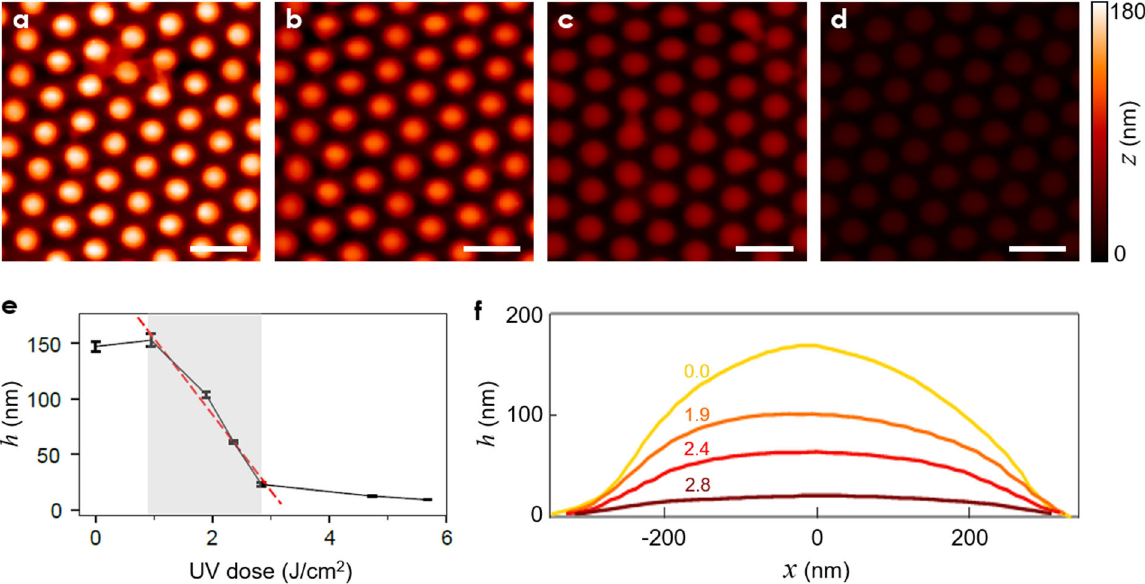
Figure 4. ( a – d ) AFM scans of the UV ‐ controlled nanoimprinted nanolenses. The UV doses were: ( a ) 0.0, ( b ) 1.9, ( c ) 2.4, and ( d ) 2.8 J/cm 2 (scale bars: 1.0 μ m) ( e ) The final height h as a function of the UV dose. The bars represent the data range. ( f ) Cross ‐ sectional profiles of the nanolenses realized with different UV dose levels (specified by the text labels).